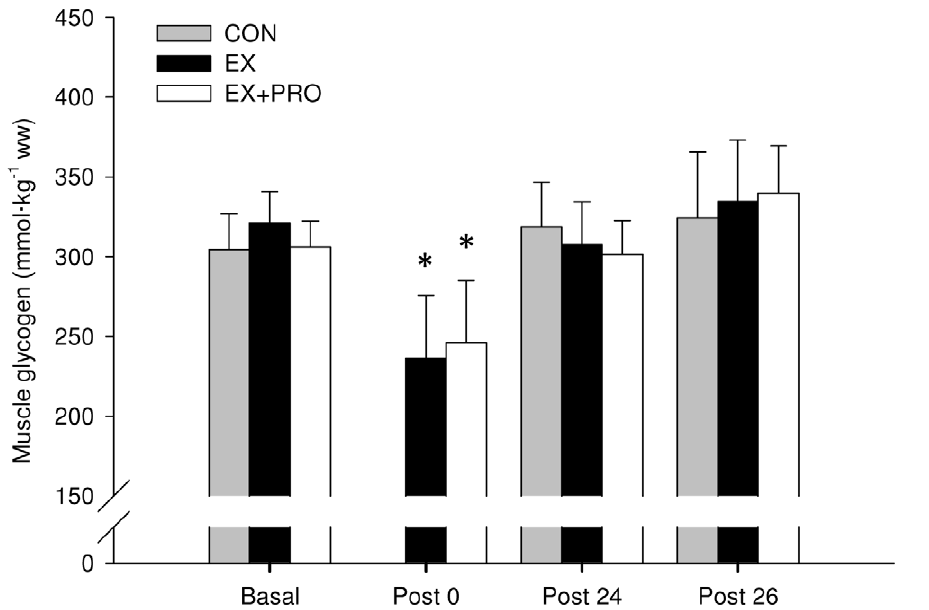
Figure 5. Muscle glycogen content. Values obtained at basal, immediately post-exercise (Post 0), 24 h post-exercise (Post 24) and immediately following OGTT (Post 26). Groups as per Table 1. Values are means 6 SEM; n =6 per group. *: significantly lower compared with basal ( P , 0.05). doi:10.1371/journal.pone.0020613.g005 PLoS ONE |